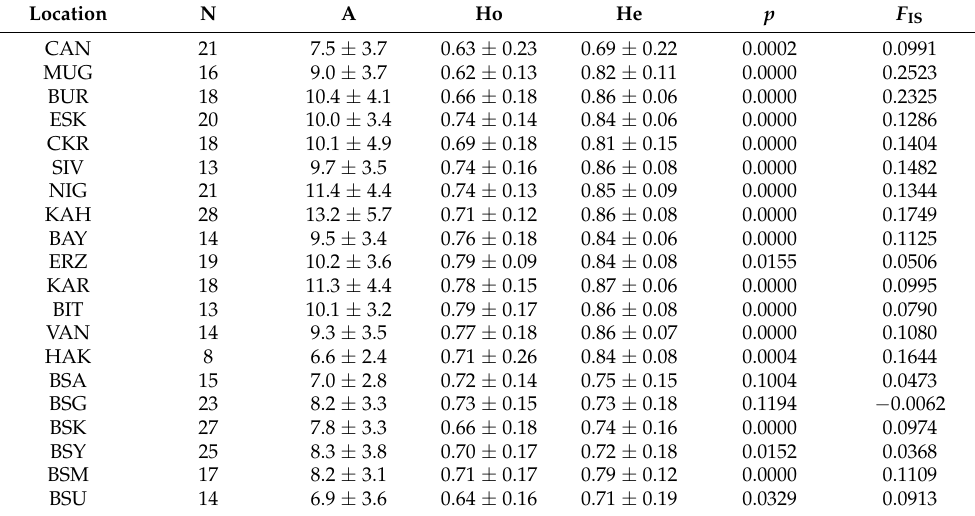
Table 4. Summary statistics ( ± SD) of genetic diversity in Chukar partridge. Haplotype diversity ( Hd ) and nucleotide diversity ( p ) expected heterozygosity (H E ), observed heterozygosity (H O ), and inbreeding coefficient ( F IS ) for each sampling area. p values for heterozygote deficiency. Location N